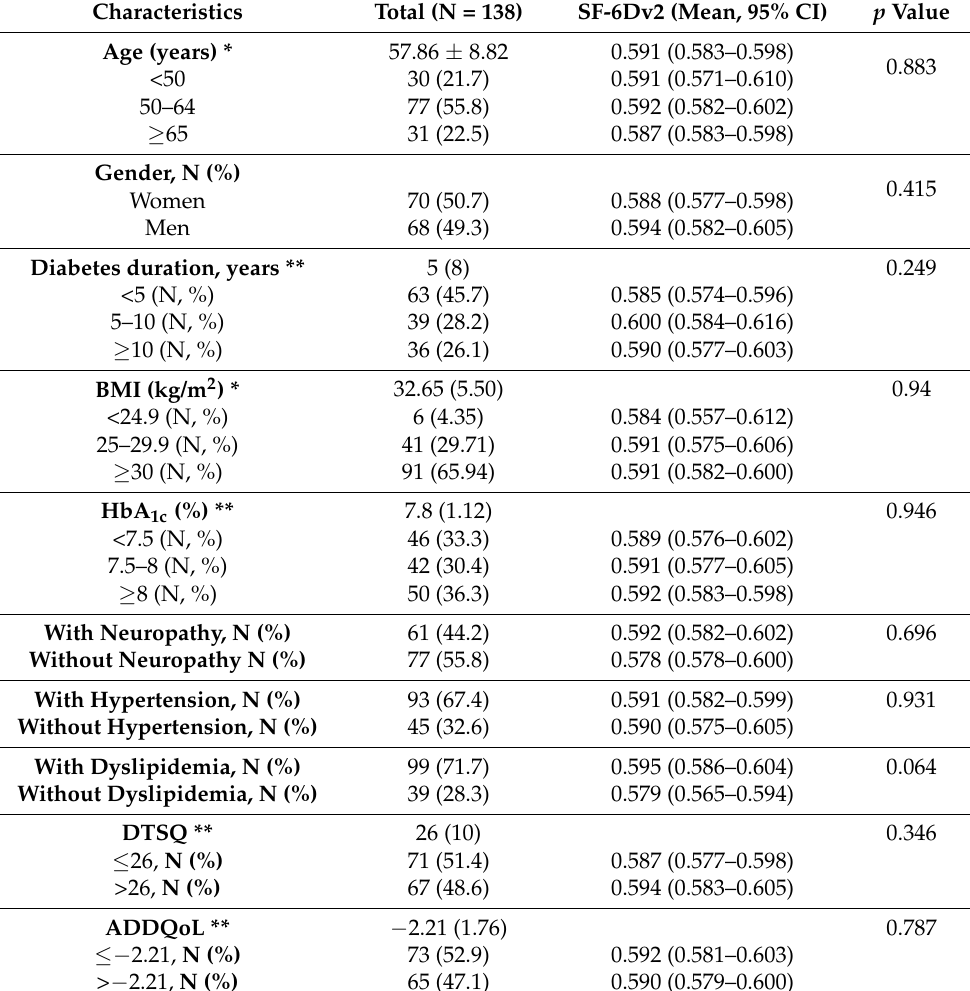
Table 4. SF-6Dv2 utility scores according to the patients’